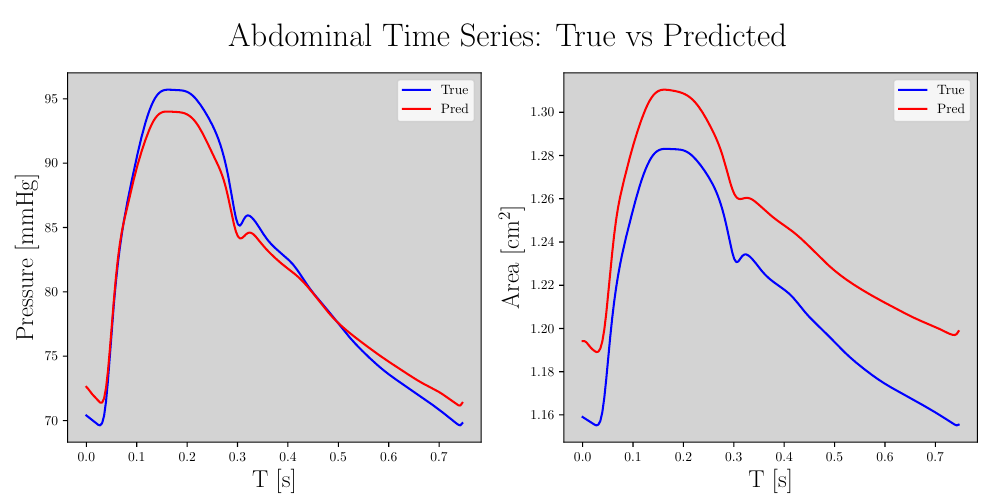
Figure 5. Comparison between true and predicted signals for pressure ( left ) and area ( right ); blue and red correspond to the true and predicted signals, respectively.